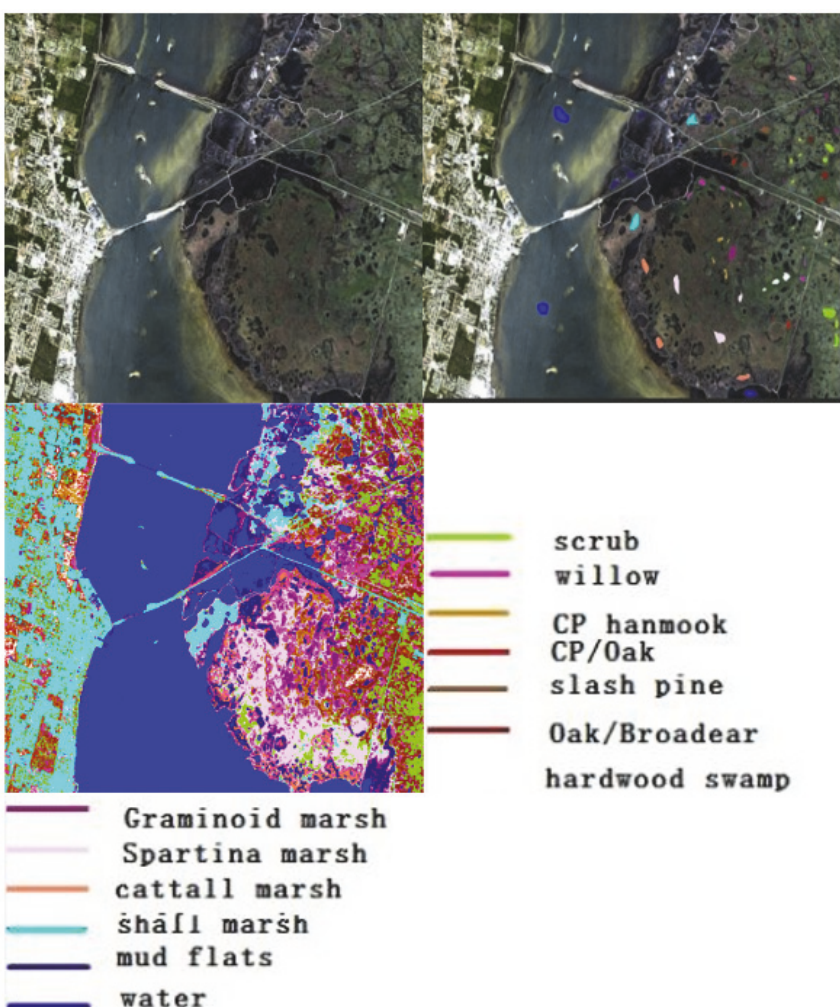
Figure 2: The synthesis true color image (bands 31, 21, and 11) and the distribution of training samples of AVIRIS data and the ground truth